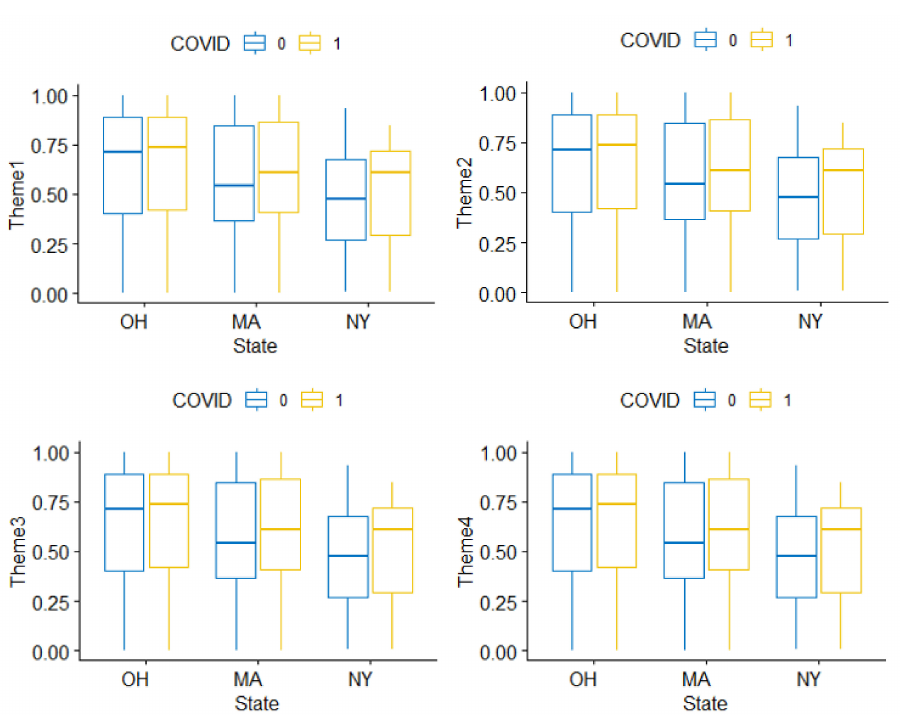
Figure A1. SVI mean plot with SE by exposure to COVID-19 and department.